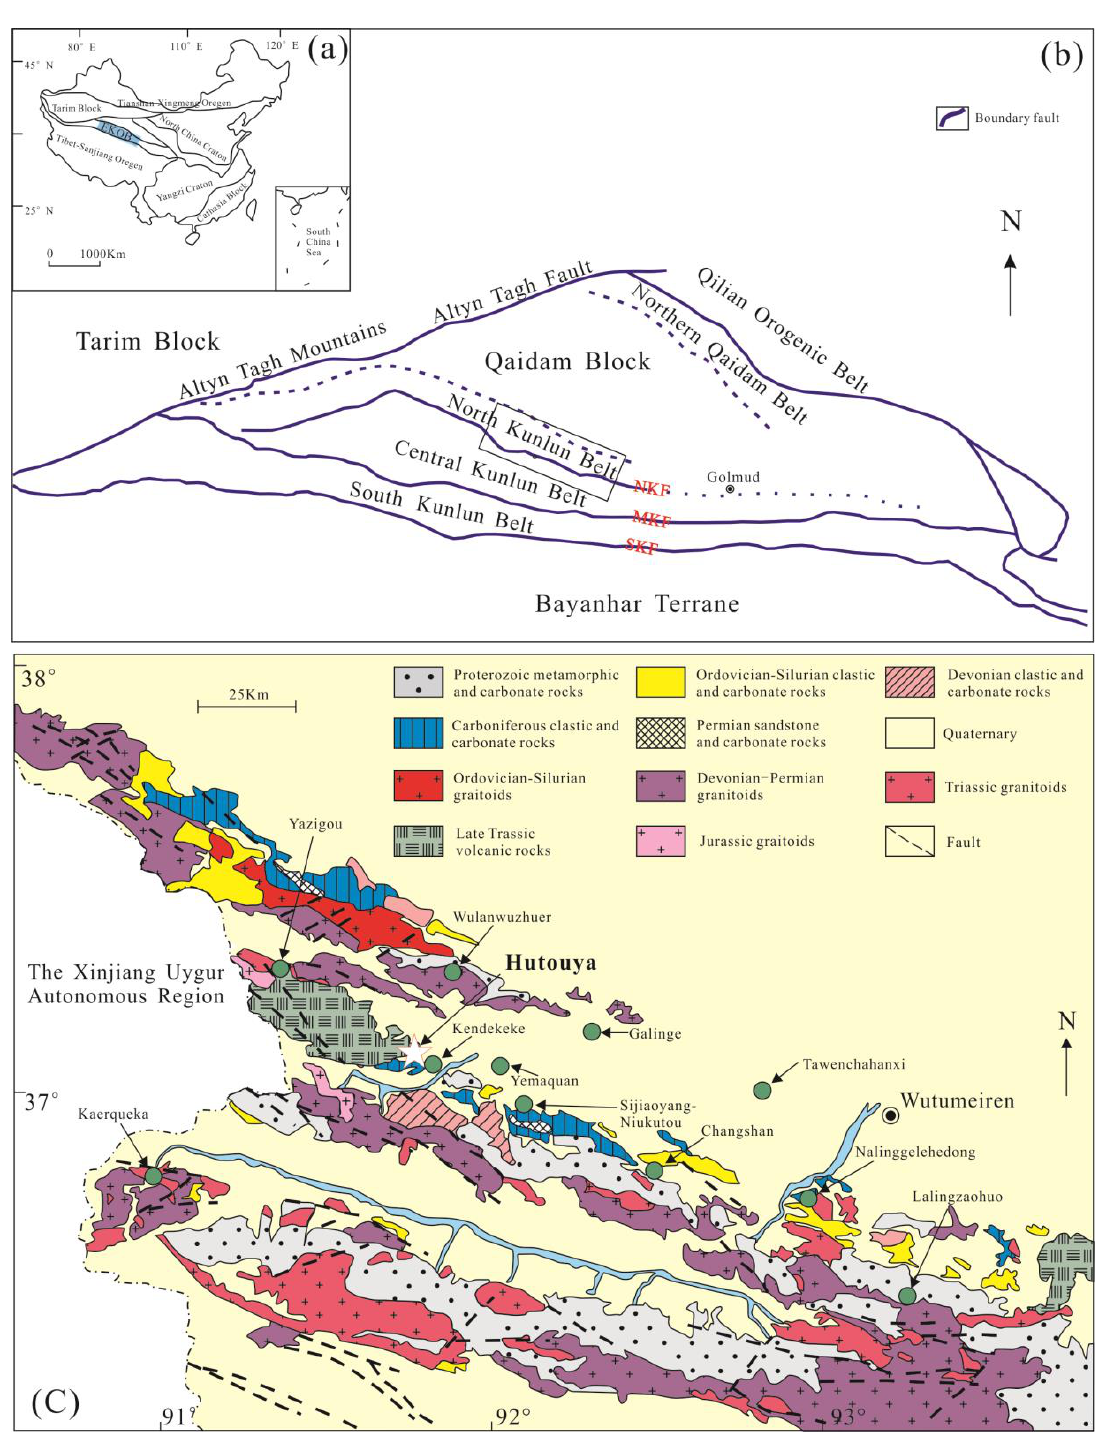
Figure 1. ( a ) Tectonic map of China showing the location of the East Kunlun Orogen Belt (EKOB). ( b ) Tectonic map of the EKOB (modified after [9]; the square frame represents the location of Qimantag area). ( c ) Geological map showing the main mineral deposit types in the Qimantag area (modified after [10]).